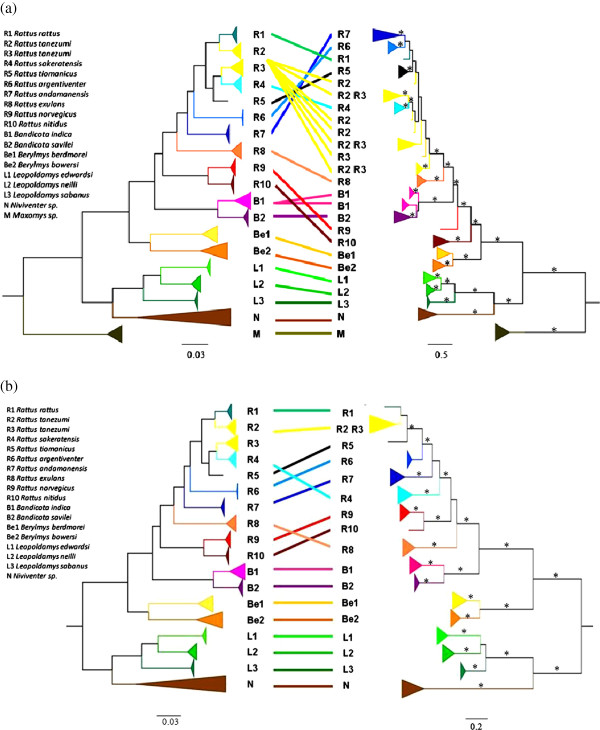
Comparison of phylogenetic trees based on Tlrs and neutral markers. Comparison of the Bayesian phylogenetic trees of Tlr4 (a) and Tlr7 (b) on the right with phylogenetic trees based on presumably neutral markers (Cytb, CoI, Irbp; for more details see Pagès et al. 2010) on the left. Abbreviations (R1, R2….M) indicate species assignment used in Pagès et al. 2010; corresponding legend is on the left. Color lines link the supported clades represented by the same species; * indicates posterior probabilities (pp) > 0.95.